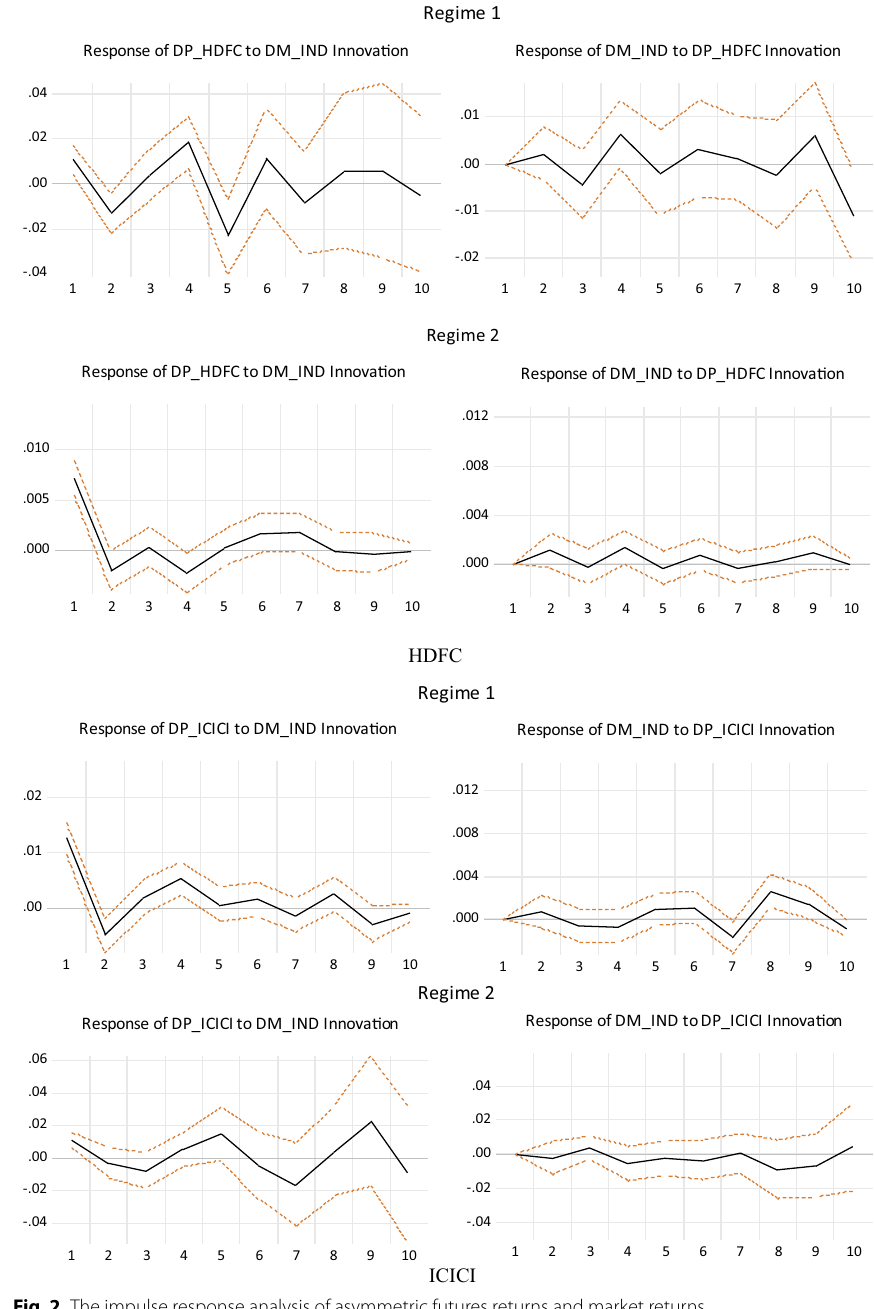
Fig. 2 The impulse response analysis of asymmetric futures returns and market